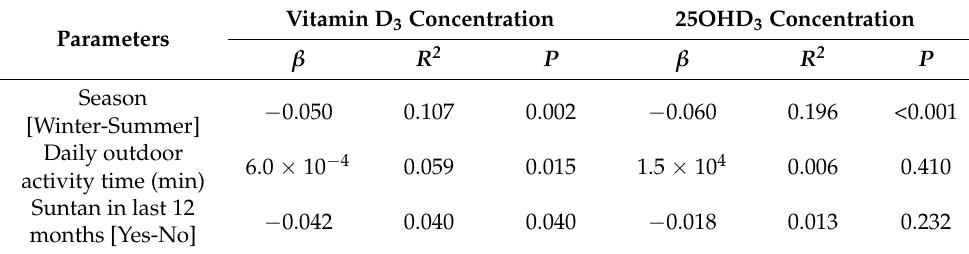
Table 5. Stepwise multiple regression analysis for parameters associated with vitamin D 3 or 25OHD